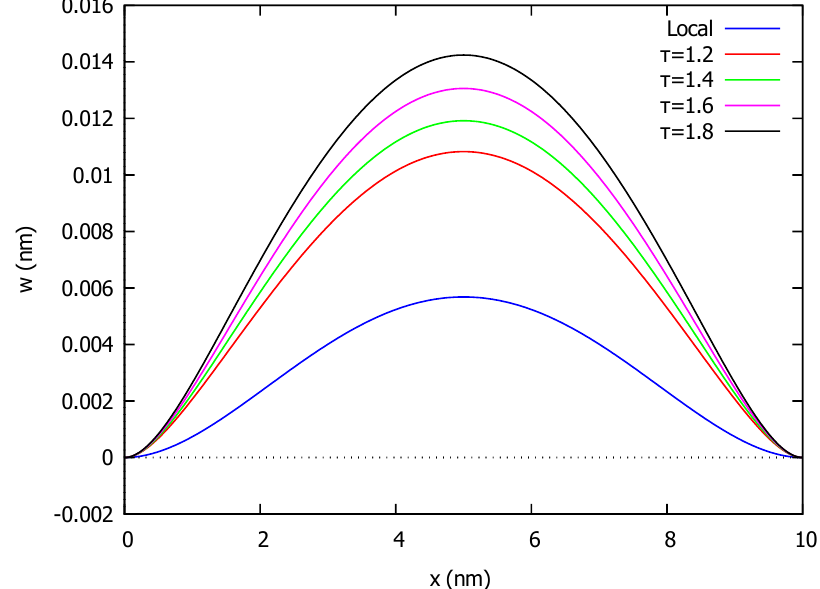
Figure 7. Deflection of clamped beam (CP) under uniform load and several values of τ